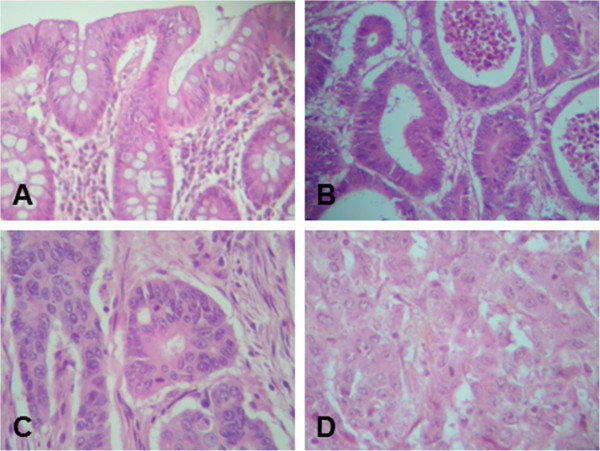
Histopathological characteristics of colon cancer tissue as compared with normal mucosa. Representative micrographs of formalin-fixed and paraffin-embedded tissues counterstained with hematoxylin and eosin. (A) Normal tissue taken 5-cm away from the tumour area (× 10); (B) well differentiated tumour (× 10); (C) moderately differentiated tumour (× 20). D: poorly differentiated tumour (× 20).